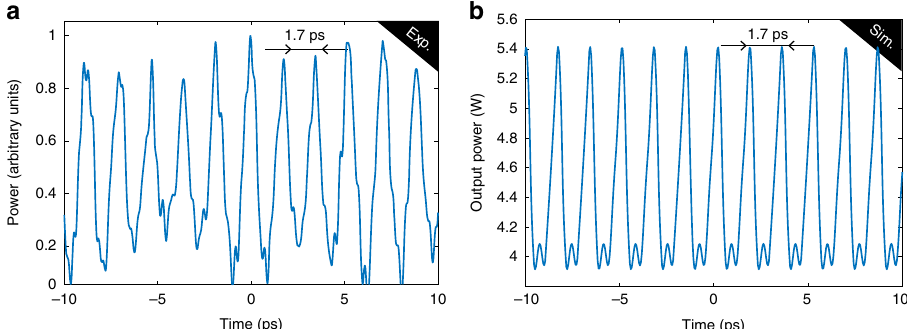
Fig. 4 Temporal dynamics. Temporal traces recorded at the output of the cavity show good agreement between experiments a and numerical simulations b . Note that in experiment the background was attenuated before sending the optical signal to the oscilloscope, this explains the arbitrary units on the y